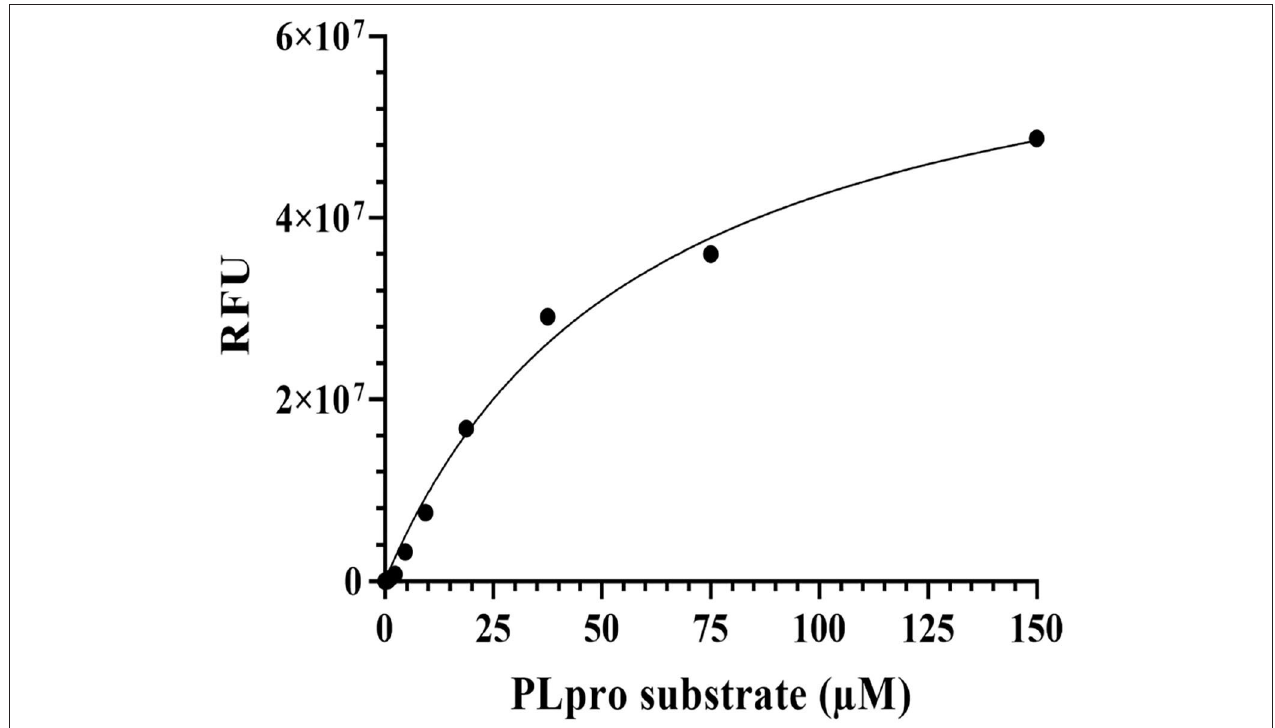
FIGURE 5 | Optimization of PLpro activity assay using Michaelis-Menten equation. PLpro enzymatic activity assay was performed using the fluorescence substrate peptide-AMC in 50 µ L reaction volume in 20mM Tris pH 7.5, 100mM NaCl, and 2mM DTT buffer conditions at 25 ◦ C. The PLpro protein reaction was kept with increasing concentrations of PLpro substrate and incubated at 37 ◦ C for 45min in biological replicates. After incubation, the fluorescence signals were monitored at 460nm (excitation at 360nm) and graphs were plotted in GraphPad prism